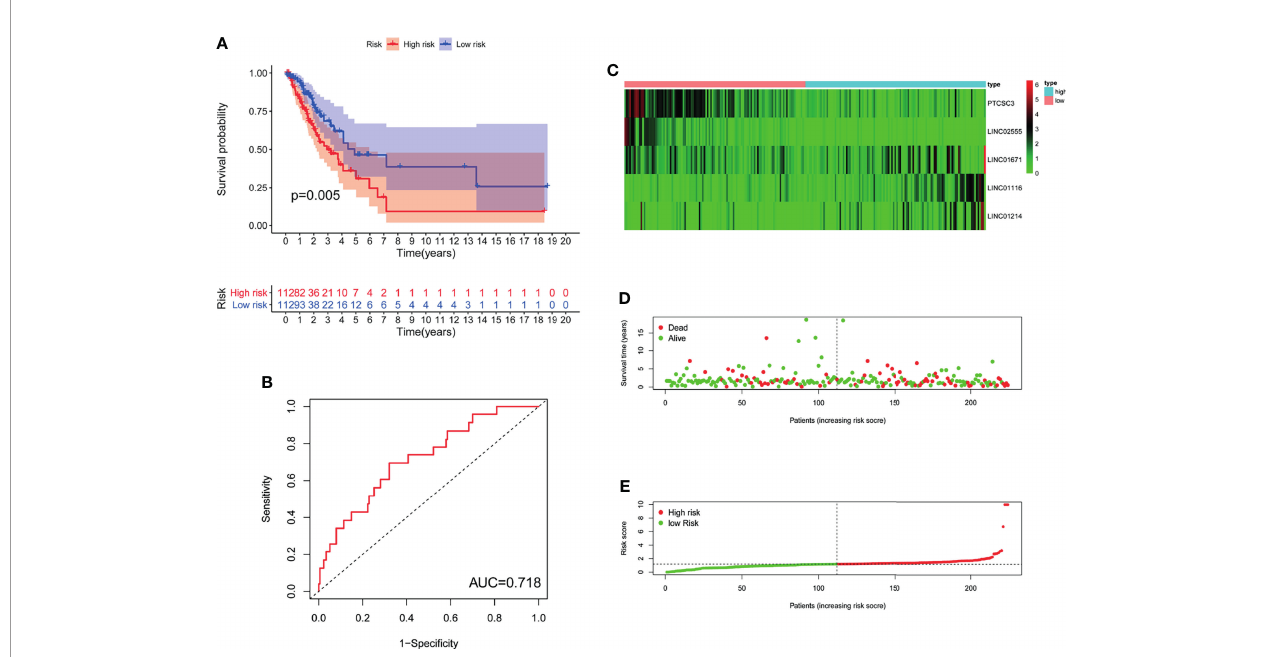
FIGURE 2 | The genomic instability-derived lncRNA signature (GILncSig) related to overall survival (OS) of LUAD in training set. (A) Log-rank test was used to draw a Kaplan Meier survival curve to predict the overall survival of GILncSig in low-risk or high-risk patients in training set. (B) Receiver Operating Characteristic (ROC) analysis of GILncSig in training set. (C) Heat map of 5 genomic instability-derived lncRNA expression patterns in training set. (D) The survival status of LUAD patients. The dotted line represents the median of the risk score; the number of deaths in the right part of the patient is greater than the left part, indicating that as the risk score increases, the risk of death increases. (E) Risk score distribution of LUAD